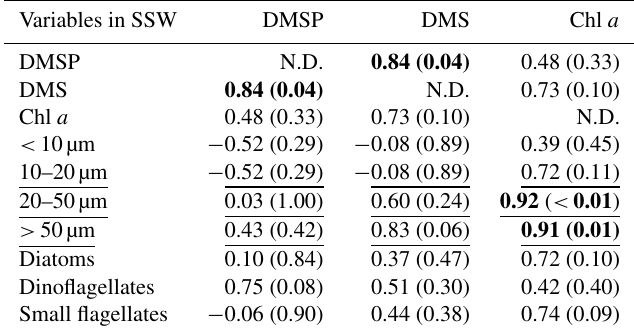
Table 3. Summary of Pearson test and Spearman’s rank correlation (underlined) for DMSP, DMS, and all ancillary variables in the SSW. The correlations are significant where r or rho (for Pearson and Spearman’s rank tests, respectively) is > 0.5 and p < 0.05, as indicated in bold. The size fraction biovolumes were obtained from Flowcam, and the phytoplankton community composition was obtained from optical microscopy. N.D. stands for no